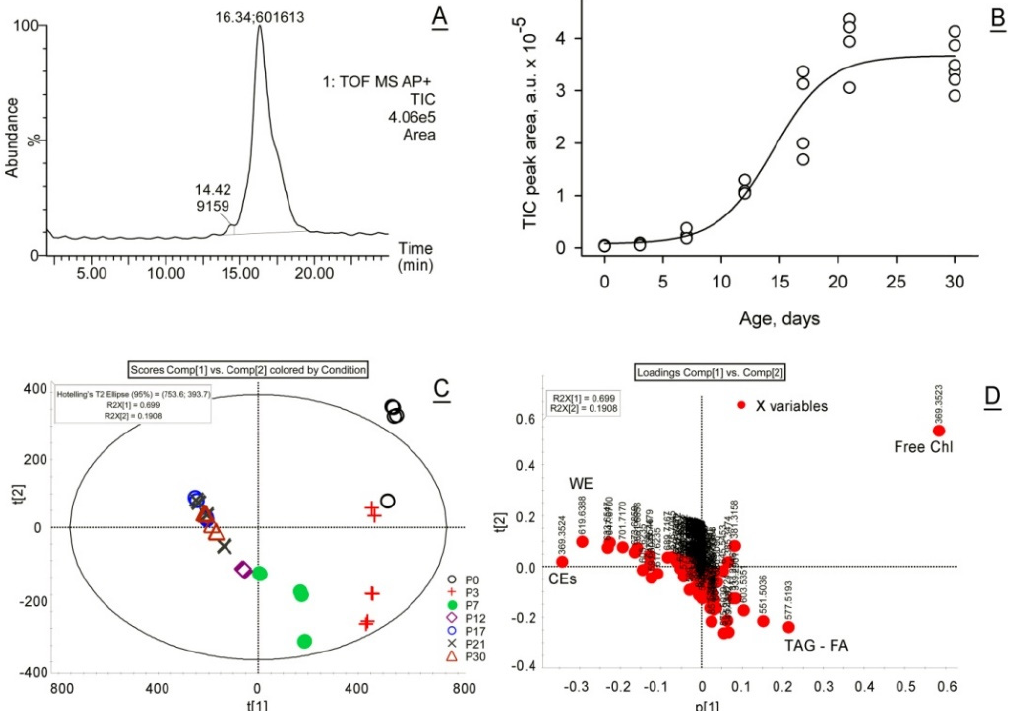
Figure 1. Lipidomic LC–MS analyses of mouse Meibomian lipids revealed the gradual accumulation of meibum in the tarsal plates and its qualitative changes in developing and maturing meibomian glands. ( A ) Total ion chromatograms recorded in LC–APCI MS experiments in positive ion mode were used to estimate the lipid content in TP extracts by measuring the total peak areas. A typical chromatogram is shown. The apex of the peak is labeled as (Retention Time; Peak Area). ( B )